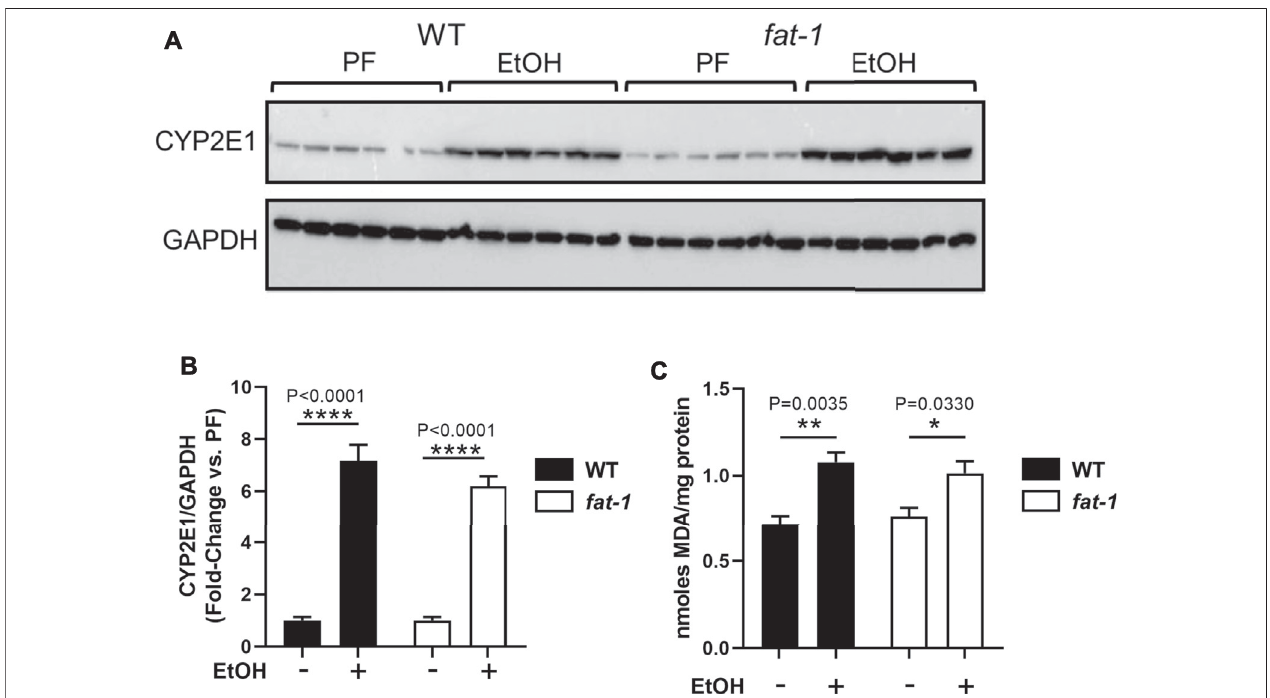
FIGURE 2 | Hepatic expression of markers of oxidative stress. (A,B) Western blot and densitometric analysis for CYP2E1 and GAPDH expression. (C) TBARS assaytodeterminelipidperoxidation levels. * p < 0.05,** p < 0.01,*** p < 0.001,**** p < 0.0001,one-wayANOVA(comparisonsnotsigni fi cantif unlabeled) n (cid:1) 6miceper group chosen randomly of the total 8 –